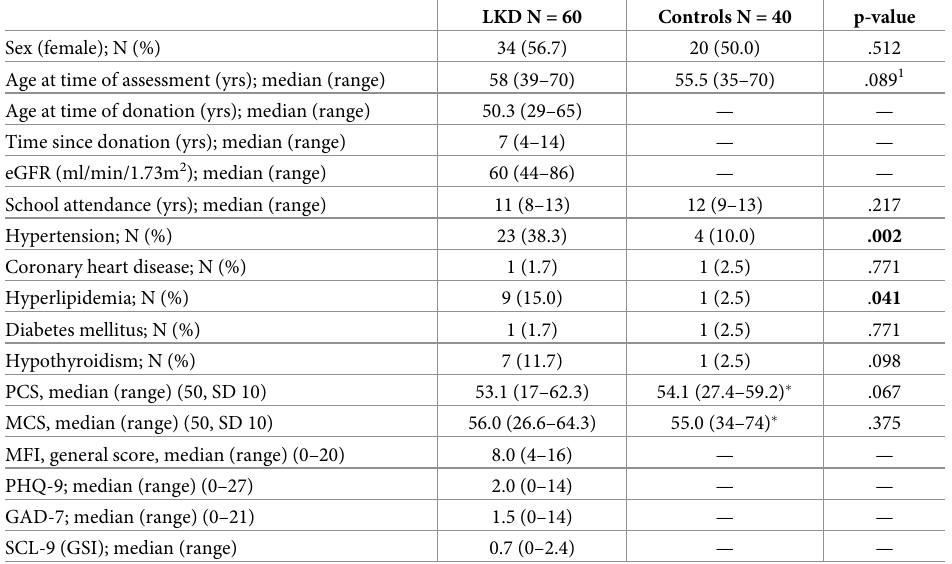
Table 1. Comparison between living kidney donors (LKD) and controls.